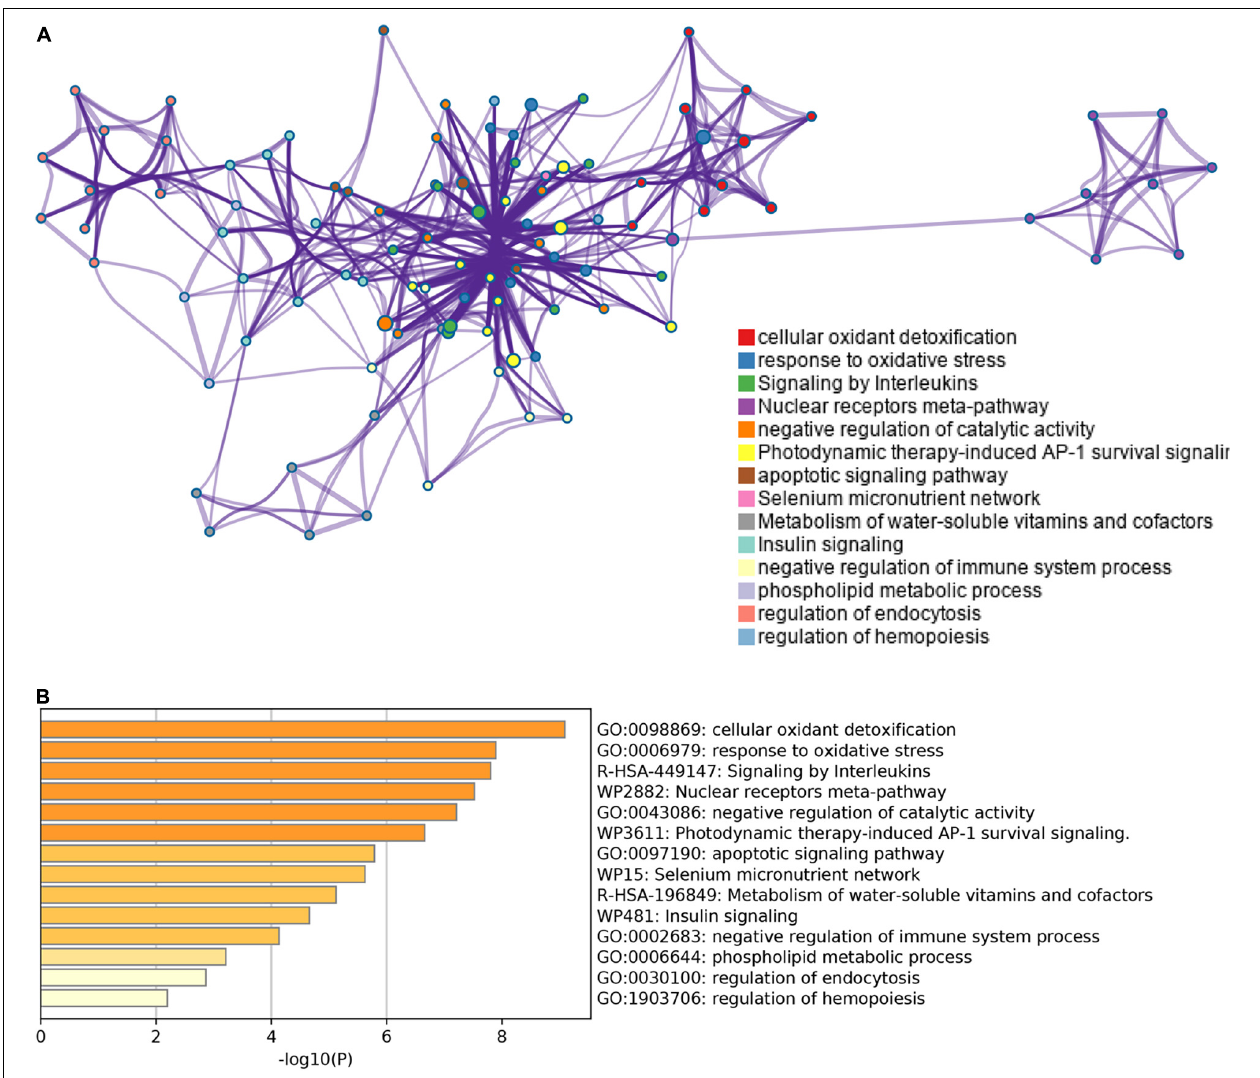
FIGURE 3 | The enrichment pathway analysis of ferroptosis-related DEGs. (A) The pathways network of ferroptosis-related DEGs using Metascape. (B) The enrichment pathway analysis of ferroptosis-related DEGs using Metascape.